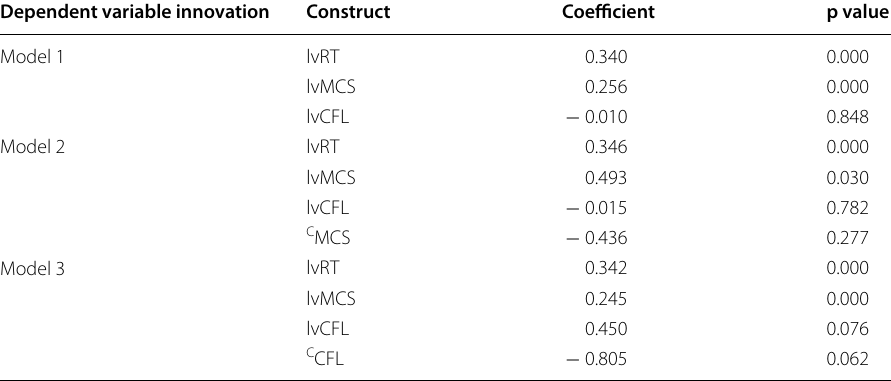
C indicates the copula term in the model. Lv latent variable; RT risk taking; MCS Management Control System; CFL CEO’s financial literacy